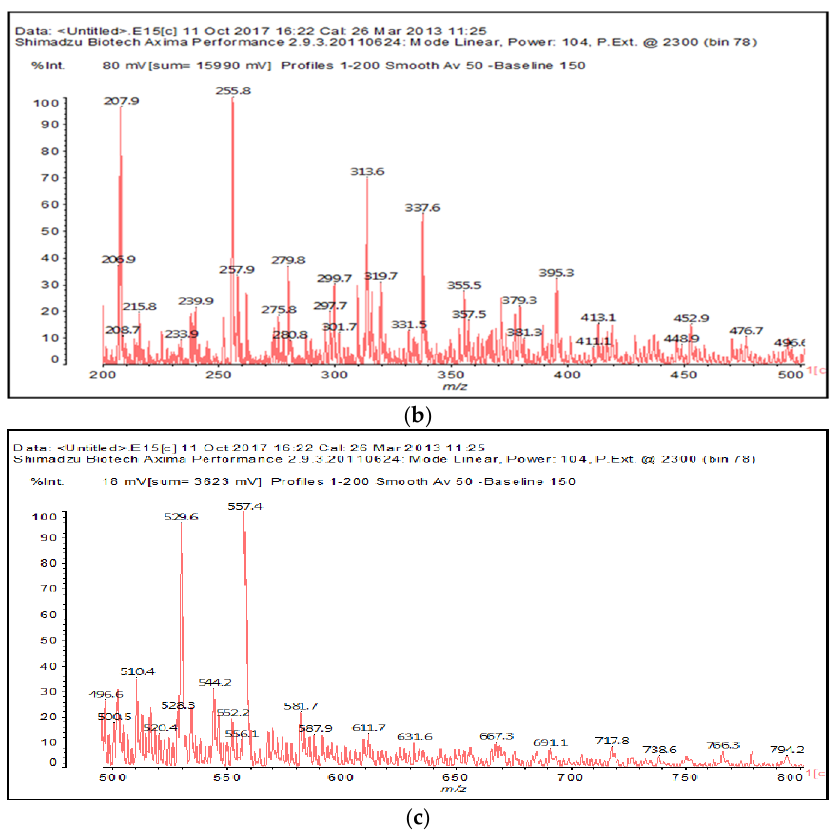
Figure 6. MALDI-ToF spectrum of the formation of the MGG’ resin in the presence of N -methyl-2-pyrrolydone hydrogen sulphate ([HNMP] [HSO 4 − ]) ionic liquid: ( a ) 20–200 Da range. ( b ) 200–500 Da range. ( c ) 500–800 Da range. Table 6. Oligomers formed by the reaction of MGG’ with and without IL.